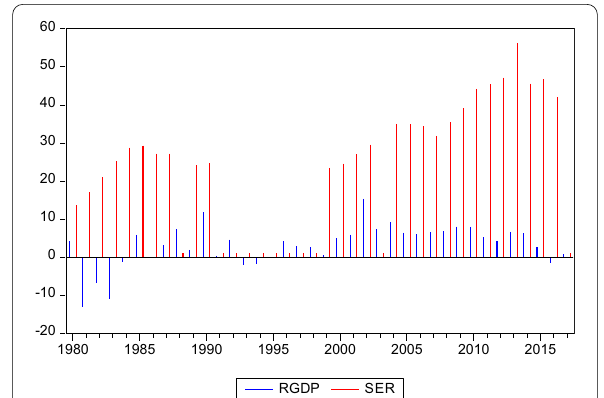
Fig. 1 The trends between real gross domestic products and government expenditure